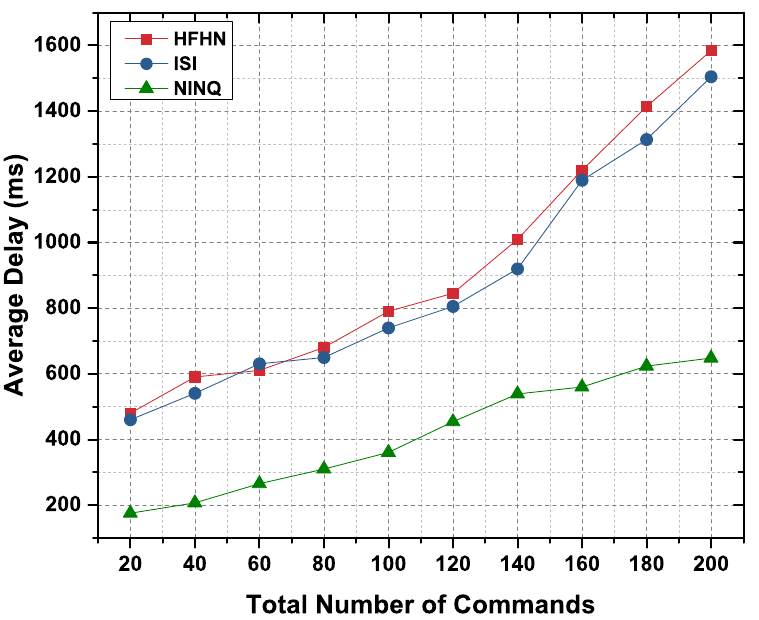
Figure 17. Average delay in a network as function of total number of